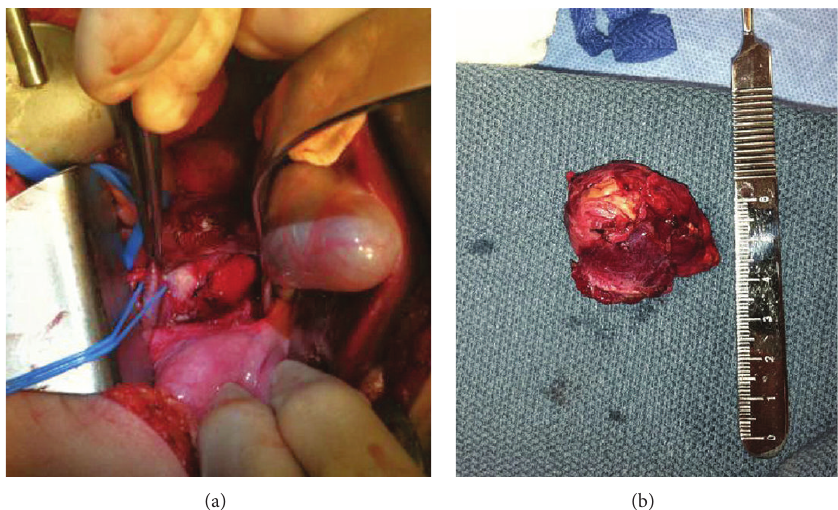
Figure 2: Intraoperative (a) and postoperative (b) views of the retroperitoneal mass.